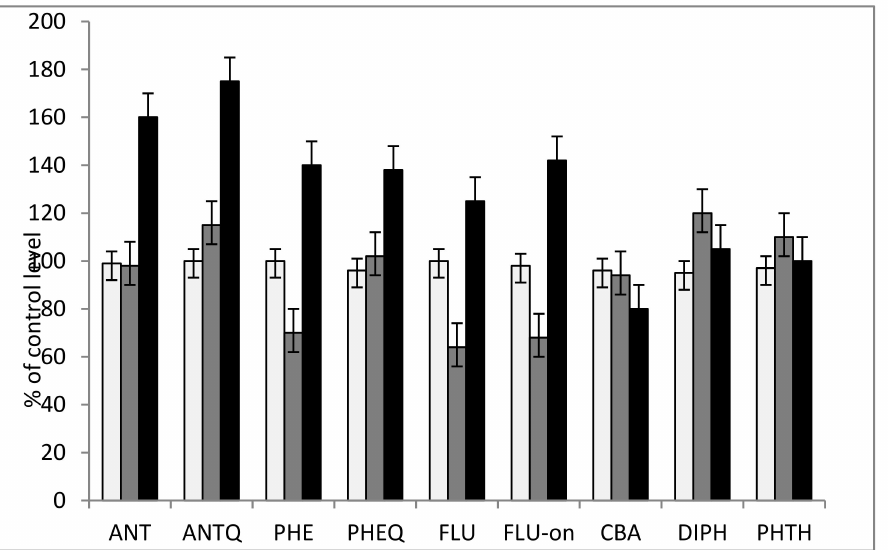
Figure 6. Effect of PAHs and their fungal metabolites on germination of seeds ( □ ), length of shoots